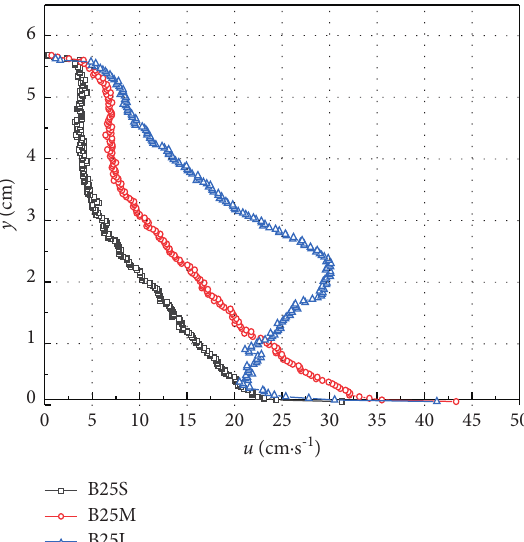
Figure 12: The vertical distribution of the lateral turbulent intensities in different working conditions ( x �